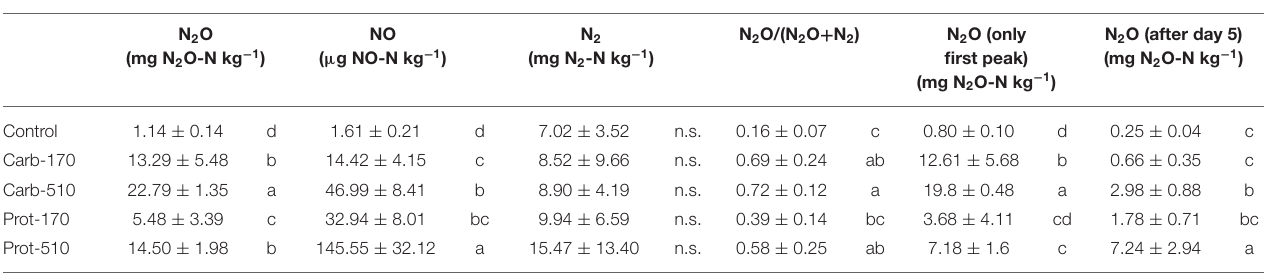
TABLE 4 | Cumulative N gas emissions (mean ± standard deviation for n = 4, for Prot-170 n = 3).